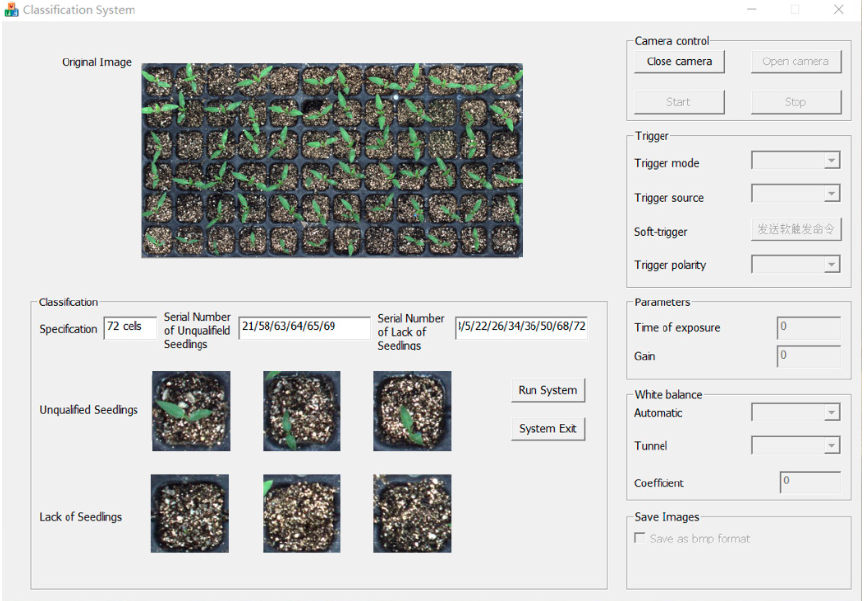
Figure 11. Classification system software.